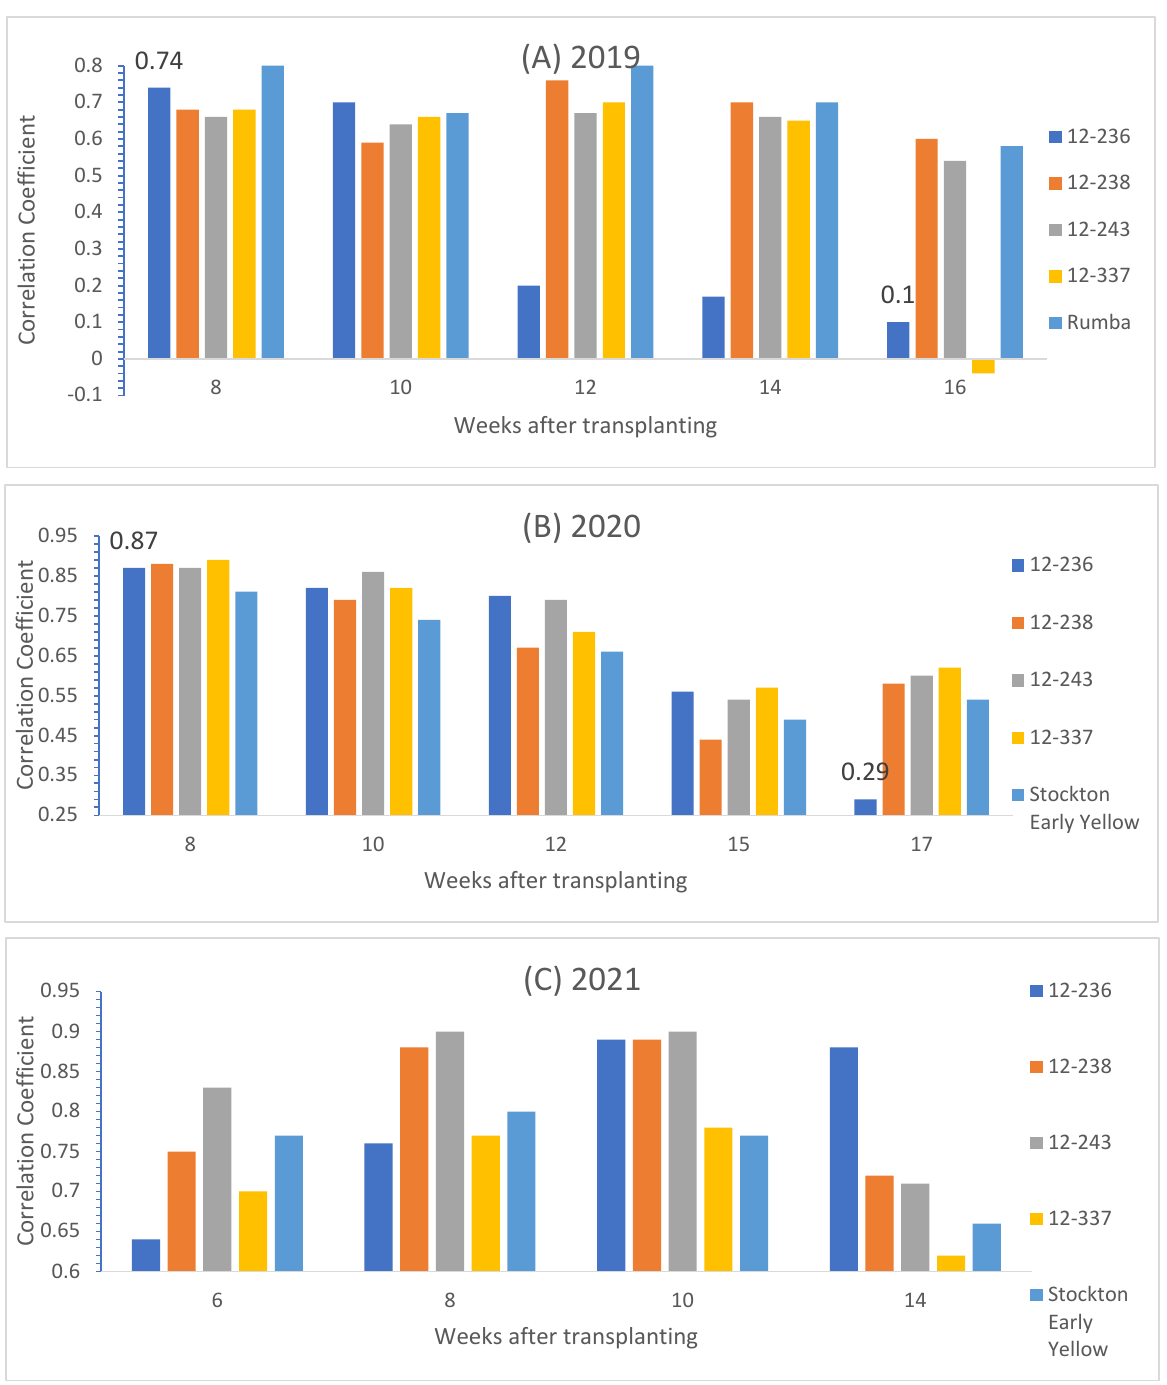
Figure 3. Correlations between plant height and leaf number through the growing season and for entries on per plant basis in ( A ) 2019, ( B ) 2020 and ( C ) 2021, at p < 0.001 significance level.